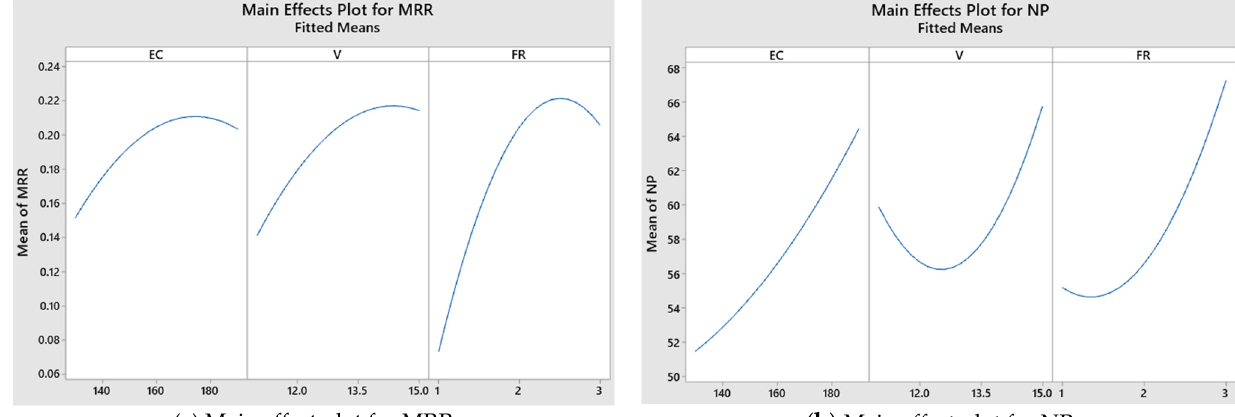
Figure 10. Interaction plots for MRR and NP. 6. Multi-Objective Optimization of ECM Process Parameters 6.1. RSM Optimization Tool Since the RSM as a DOE strategy was employed in this work, the optimum process parameters were obtained with its built-in optimization tool. The RSM optimization tool used the steepest ascent (SA) method combined with the desirability function (DF) for finding the optimum parameters. The variables and response constraints were set as shown in Table 8. Table 8. Limits of process and performance parameters. Response